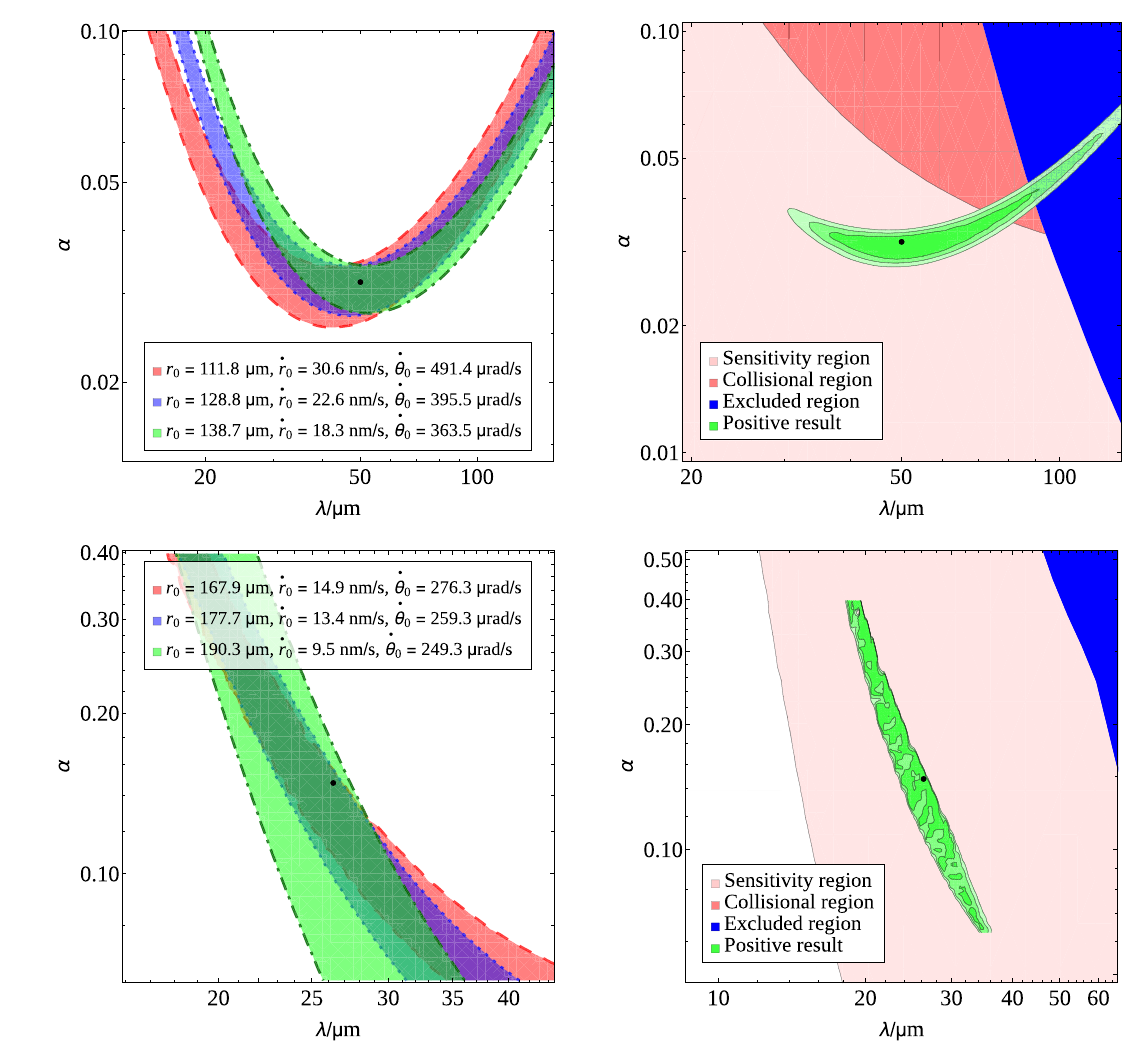
Fig. 15 Region in the ( λ , α ) plane compatible with an artificially gen- erated signal that includes a fixed Q 3 background (black dot). Top row ( Case 1 ):thesignalhasbeengeneratedfor ¯ λ = 5 . 12 μ m and ¯ α = 0 . 031, with ¯ Q 3 = 0 . 005 μ m (and we have considered Q 2 = Q 4 = 0 for sim- plicity). For the fits we have considered Q 3 ≤ 0 . 05 μ m. Bottom row ( Case 2):thesignalhasbeengeneratedfor ¯ λ = 26 . 3 μ m and ¯ α = 0 . 148, with ¯ Q 3 = 0 . 05 μ m. For the analysis we have used Q 3 ≤ 0 . 5 μ m.